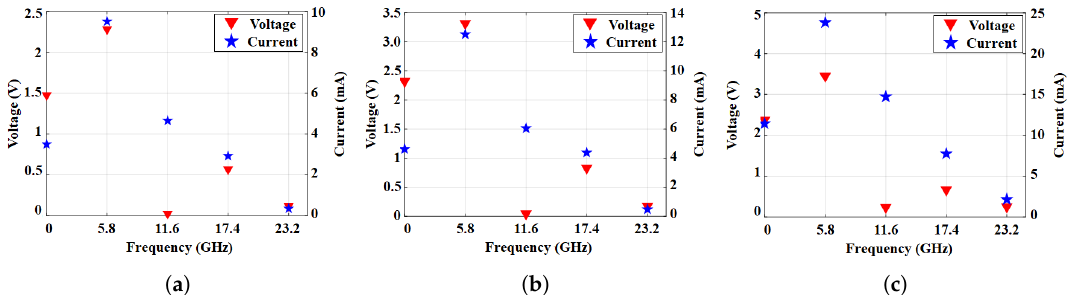
Figure 7. Diode harmonic components of voltage and current according to the number of stages; ( a ) one—stage HTVM; ( b ) two—stage HTVM; ( c ) three—stage